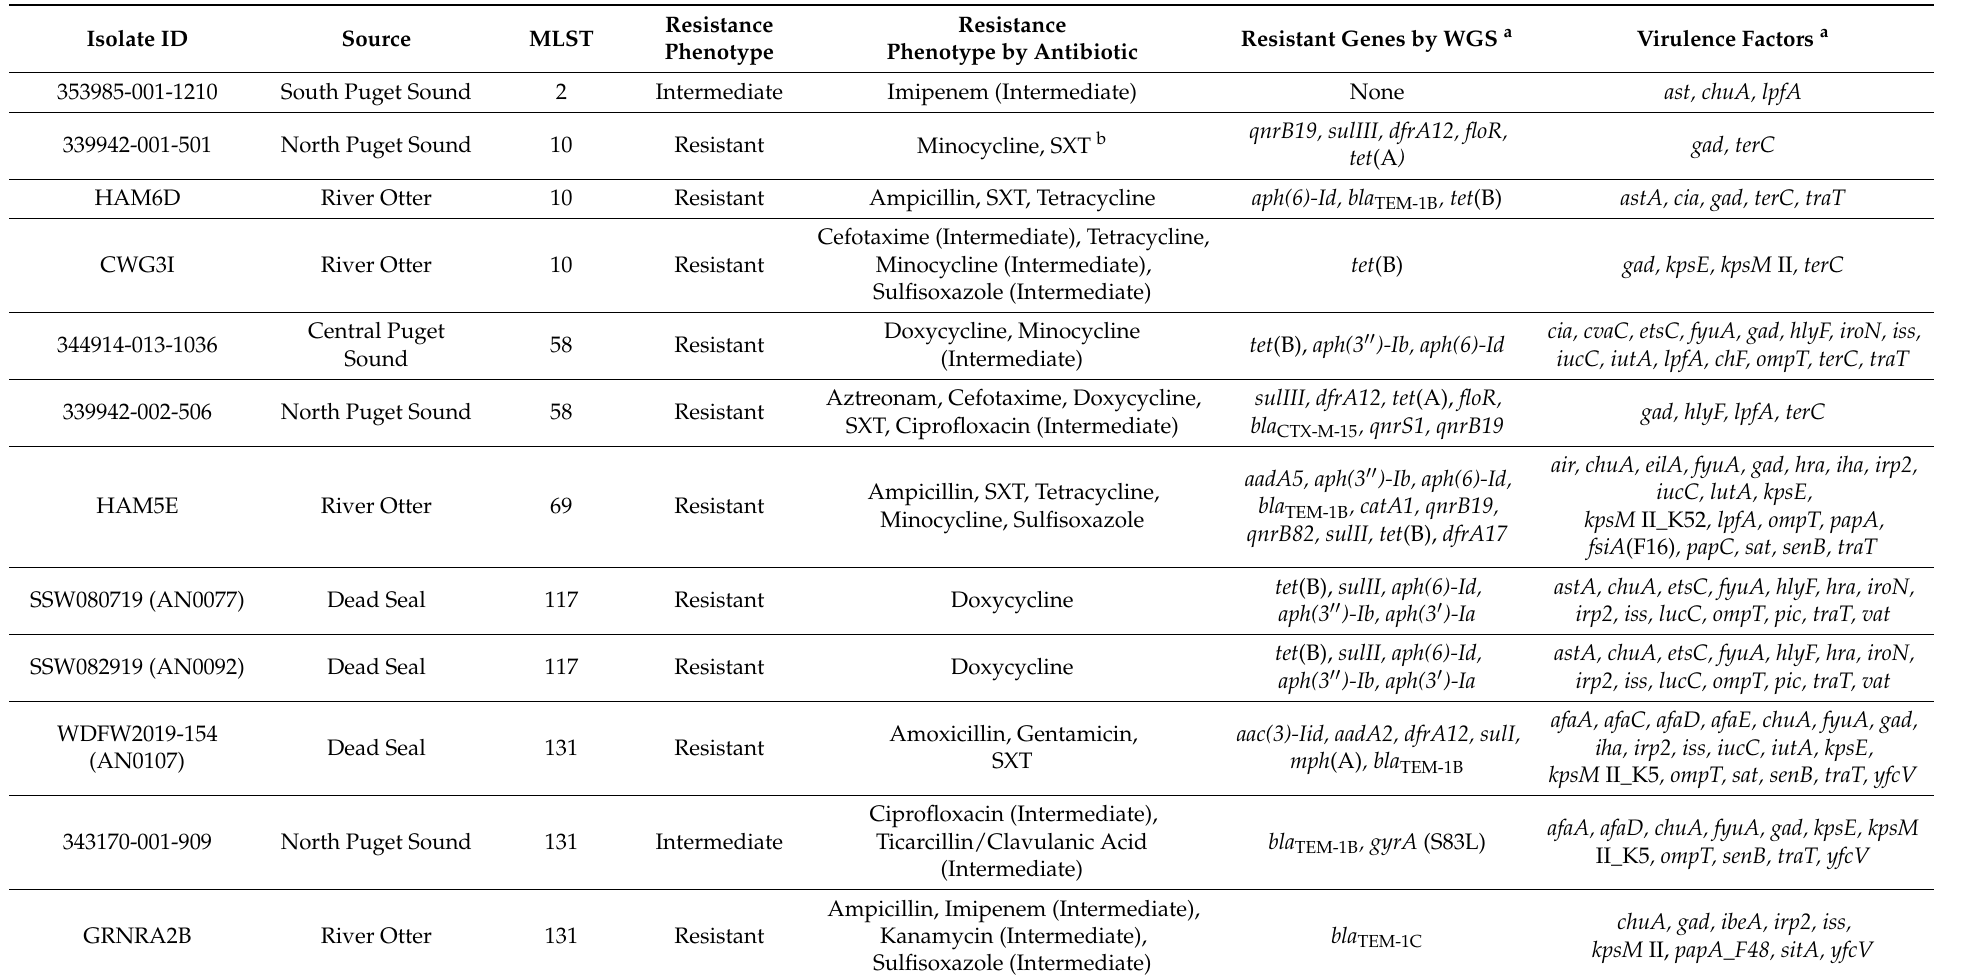
Table 2. The 51 nonsusceptible E. coli antibiotic phenotype, genotype, and virulence